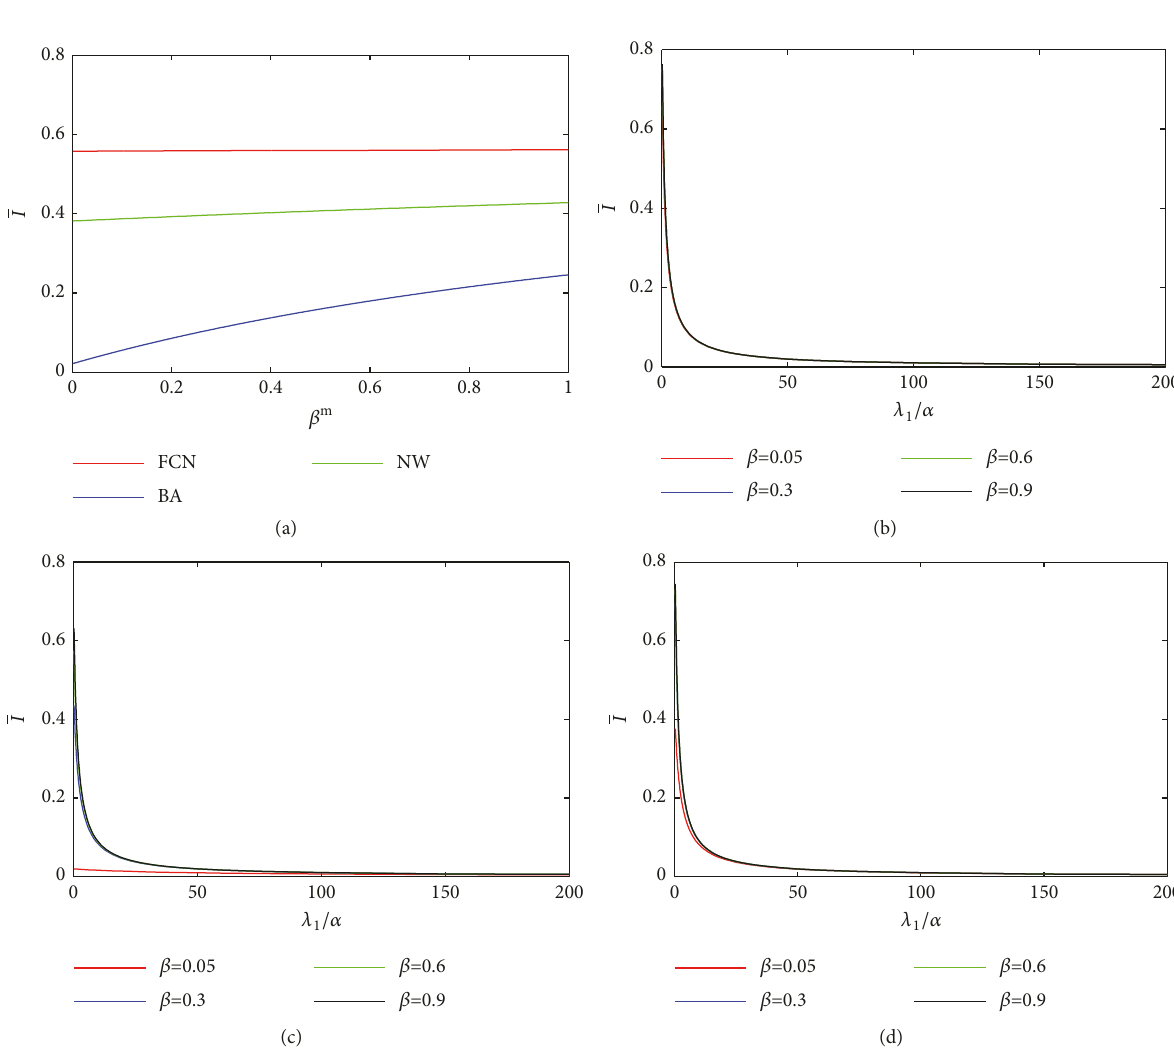
Figure 6: (a) The influenceof the infected rate 𝛽 𝑚 of media on network averageinfected states, and the curves from top to bottom correspond to the fully connected network, NW small-world network and BA scale-free network, respectively. The influence of the potential spreading rate 𝜆 1 /𝛼 on network average virus at different values of 𝛽 for the fully connect network (b), NW small-world network (c) and BA scale-free networks (d). The curves from bottom to top in each subplot correspond to the value of 𝛽 = 0.05,0.3,0.6,0.9 ,